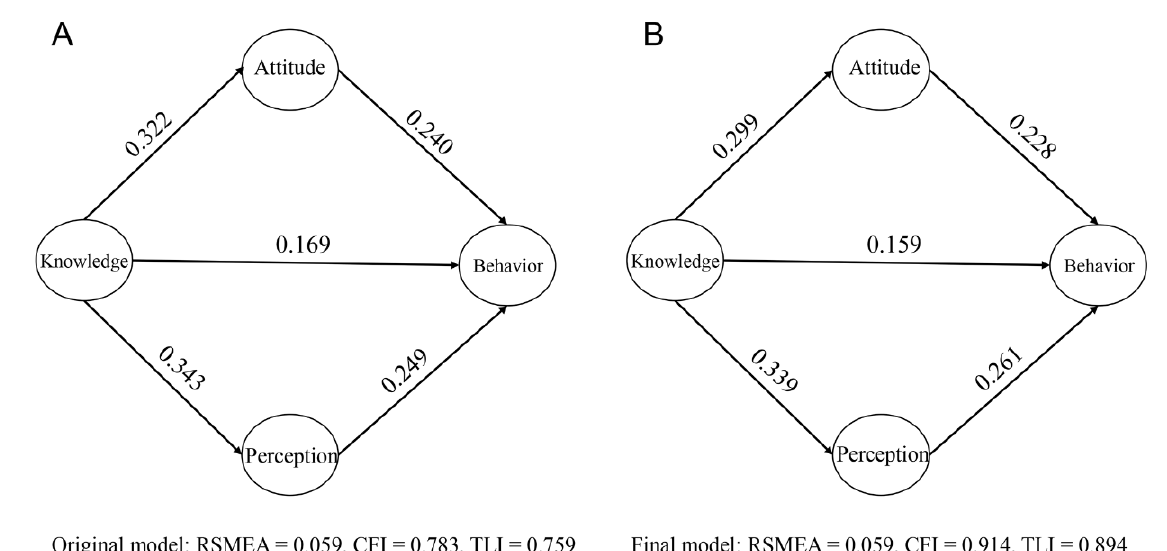
Figure 3. Validation of theoretical framework of adaptive behavior. Values refer to the standardized estimates. ( A ) refers to the original SEM. ( B ) refers to the final SEM after removing the unstandardized estimated coefficient of 0.5 and below.